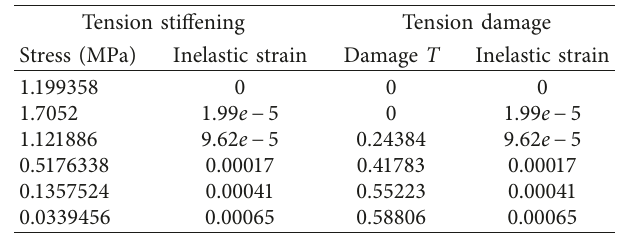
Figure 4: Layout of test setup. (a) Sensor layout and (b) test setup. Table 1: Compressive properties of concrete materials. Table 2: Tensile properties of concrete